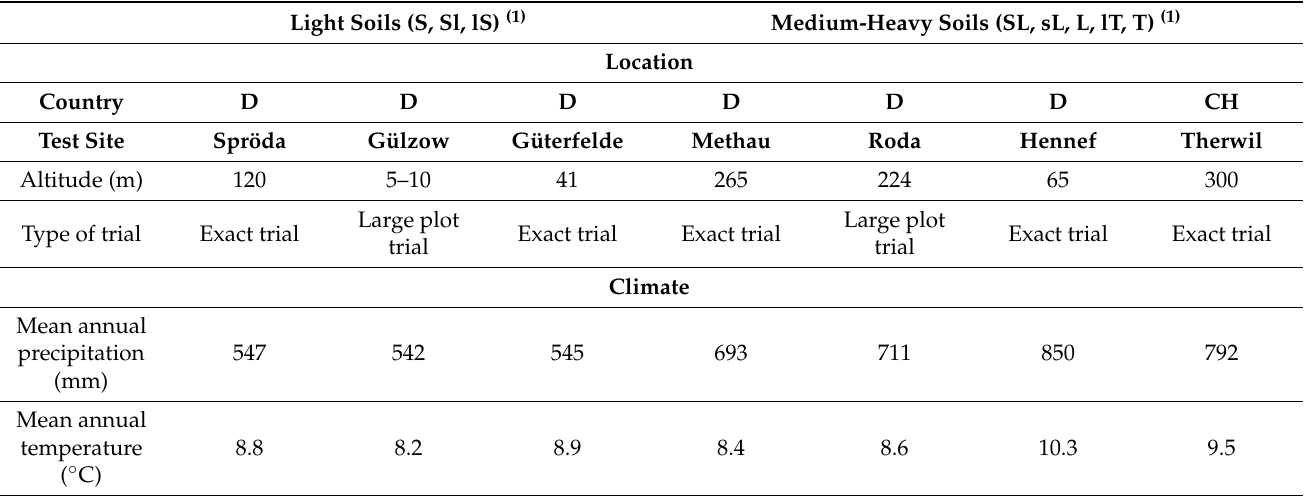
Table 1. Location, site, and management factors of the long-term field trials depending on soil type. Light Soils (S, Sl, lS)